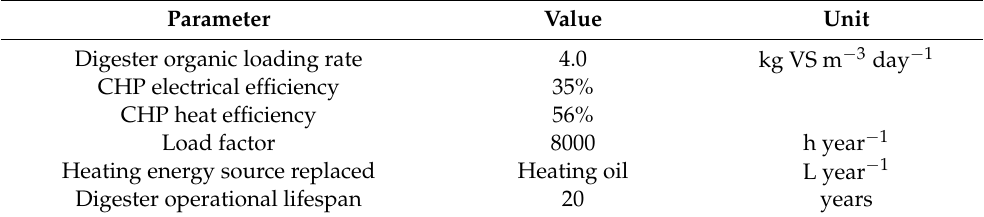
Table 1. Main parameters for the farm anaerobic digestion system from the ADAT modelling